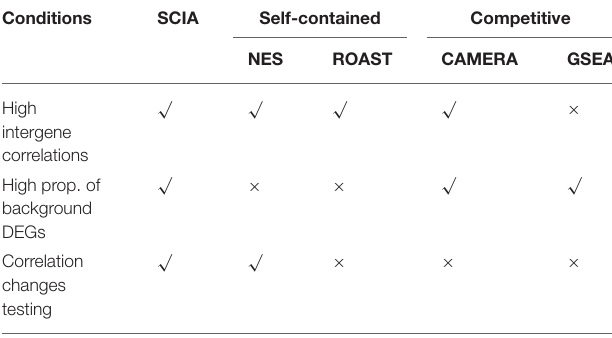
NES ROAST CAMERA GSEA